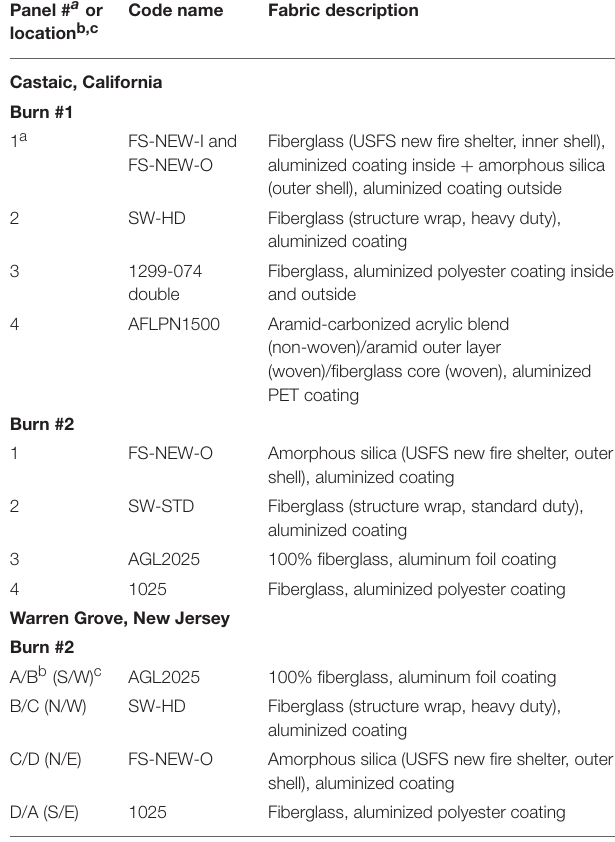
Table 1 . The laboratory performance test results for single